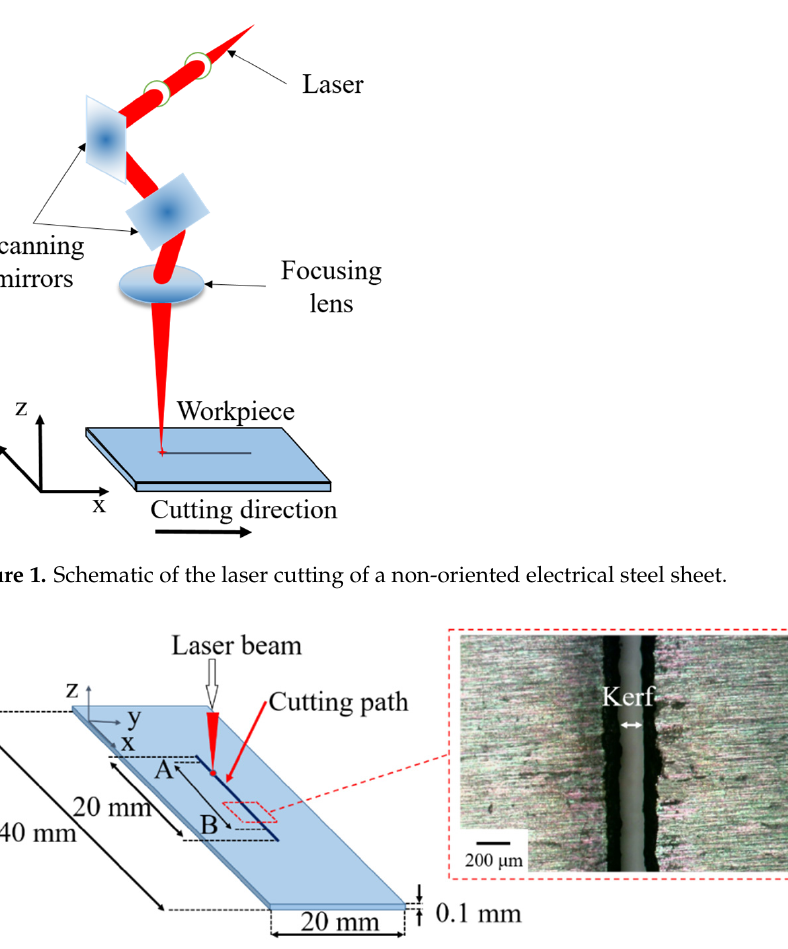
Figure 2. Schematic of specimen size and laser cutting path ( left ); optical micrograph of kerf ( right ).